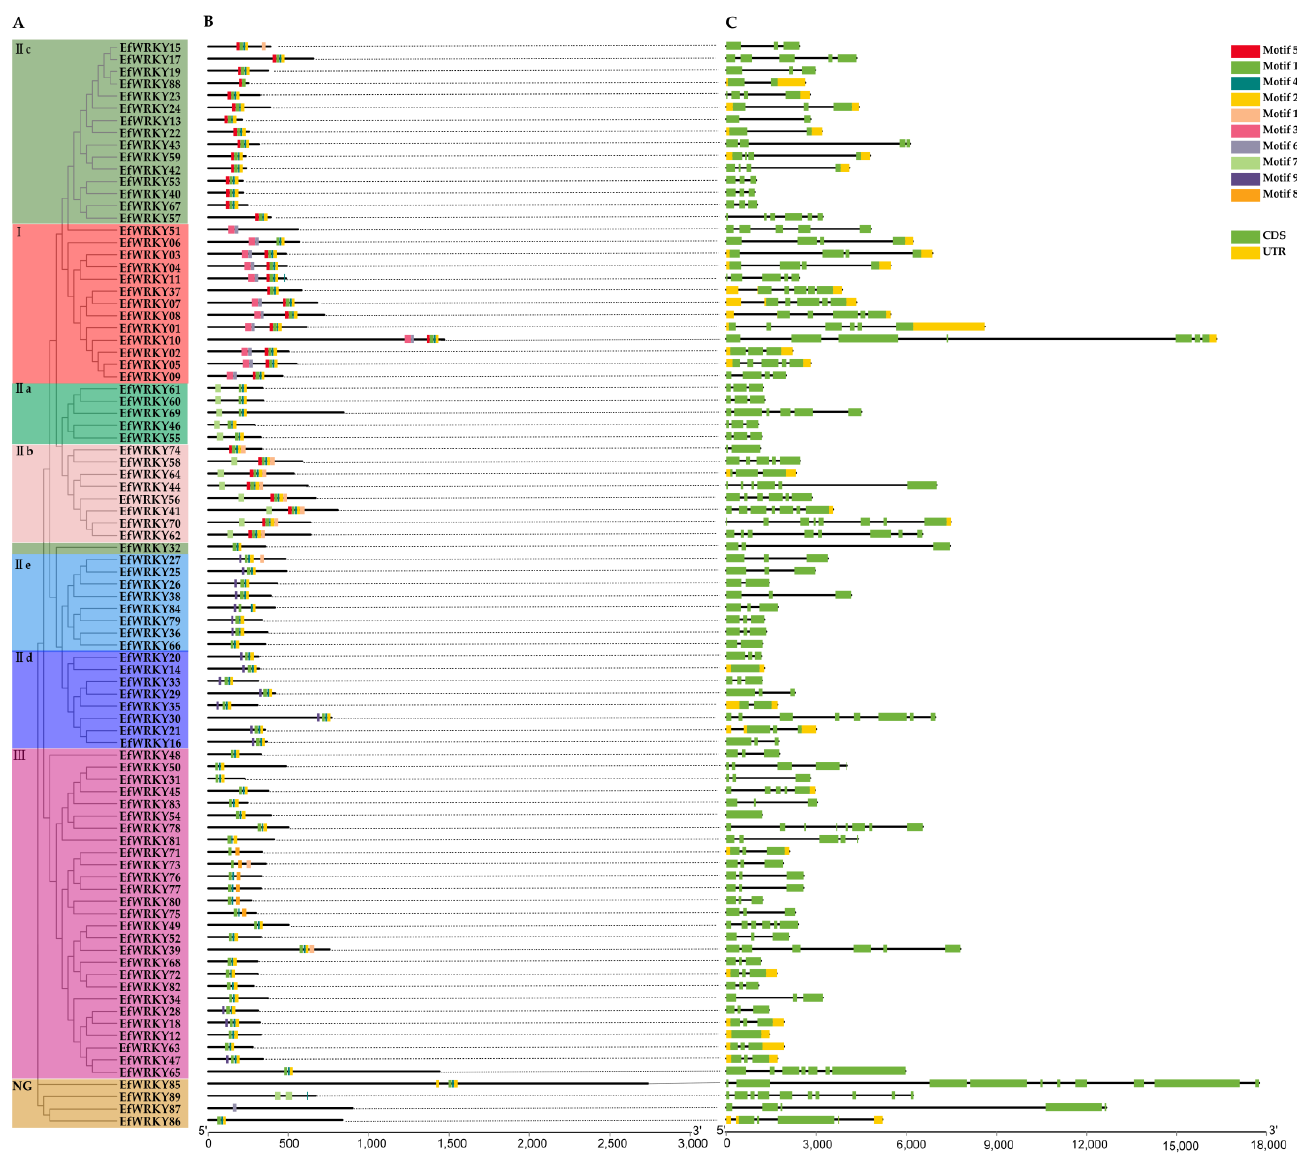
Figure 2. Conserved motifs and gene structure maps of 89 EfWRKY genes. ( A ) Phylogenetic tree of 89 EfWRKY genes. ( B ) Motif composition of 89 EfWRKY genes; a total of 10 types of conserved domains were found. The black line indicates the protein length. ( C ) Gene structure of 89 EfWRKY genes. Black lines indicate introns, green boxes indicate CDS, and yellow boxes indicate UTR.